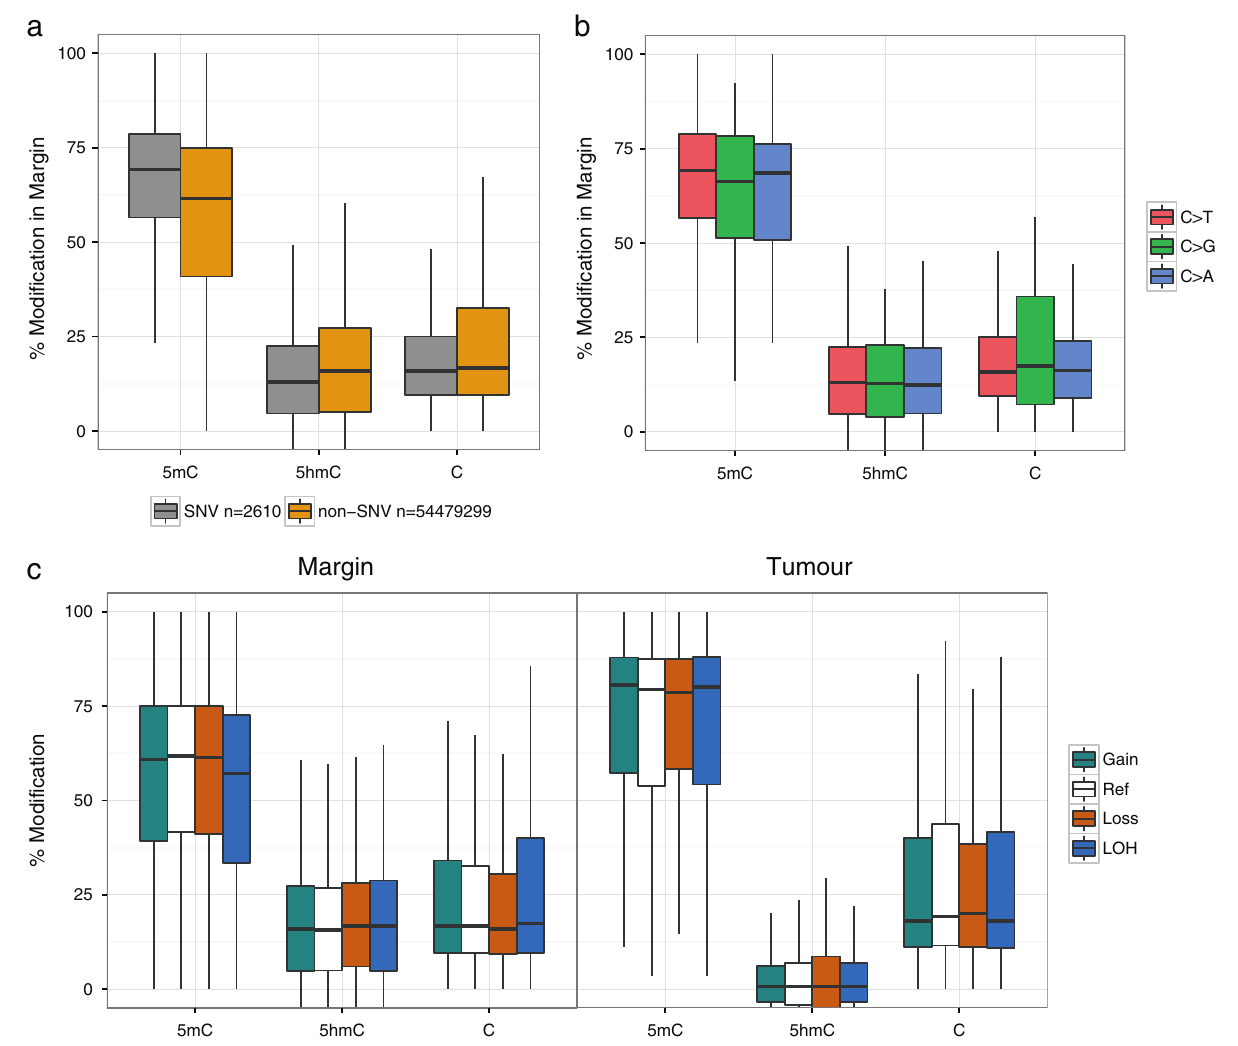
Fig. 4 Link between genetic variation and cytosine modi fi cations. a Analysis of 5mC and 5hmC levels within the margin CpG sites that are mutated in tumour (SNVs). b Differences in modi fi cation levels depending on the mutated base in tumour: C > T ( n = 2527), C > G ( n = 32) and C > A ( n = 51). c Distribution of modi fi cation levels in margin and tumour in regions with gain or loss of copies, diploid (Ref) or loss of heterozygosity (LOH) according to the CNV analysis of the tumour sample (Fig. 3c) Table 1. Overall cytosine modi fi cation levels of all CpG sites ( n = 2.7